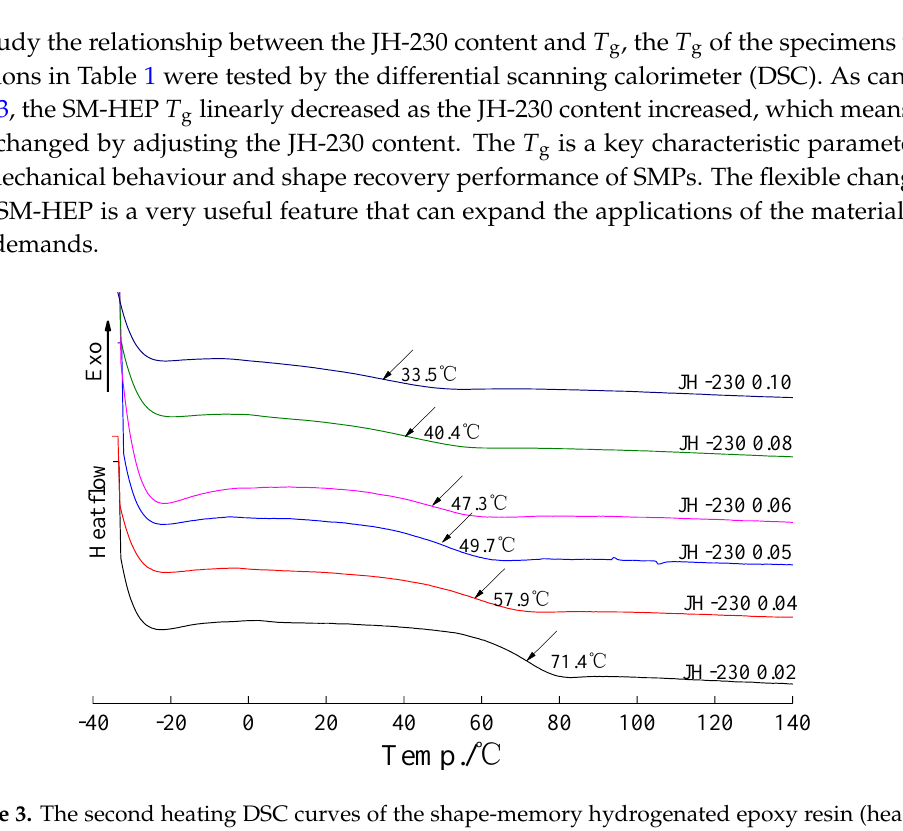
Figure 3. The second heating DSC curves of the shape-memory hydrogenated epoxy resin (heating flow = 10 °C/min).